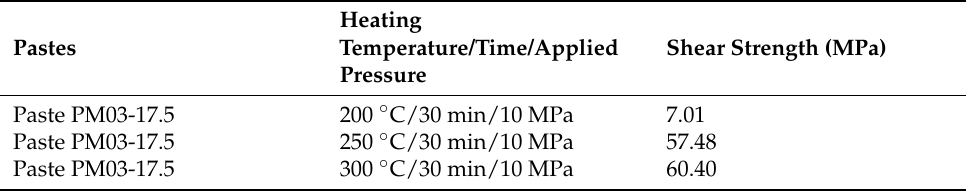
Table 5. Shear strengths of the pastes at different sintering temperatures.